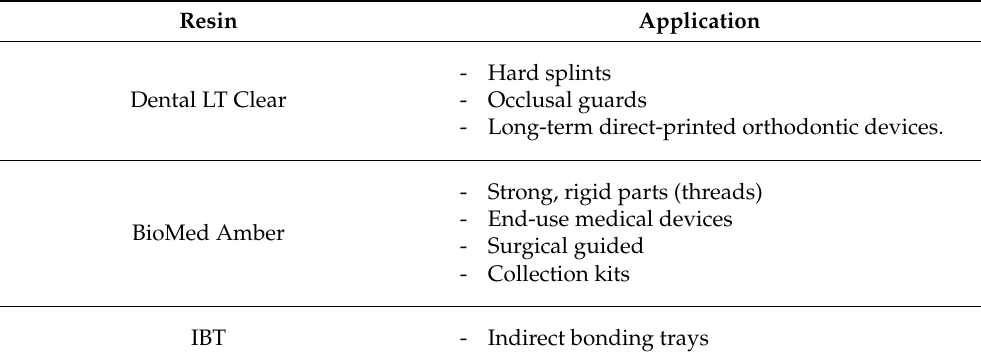
Table 18. A description of applications of the selected resins, presented by producer. Resin Application